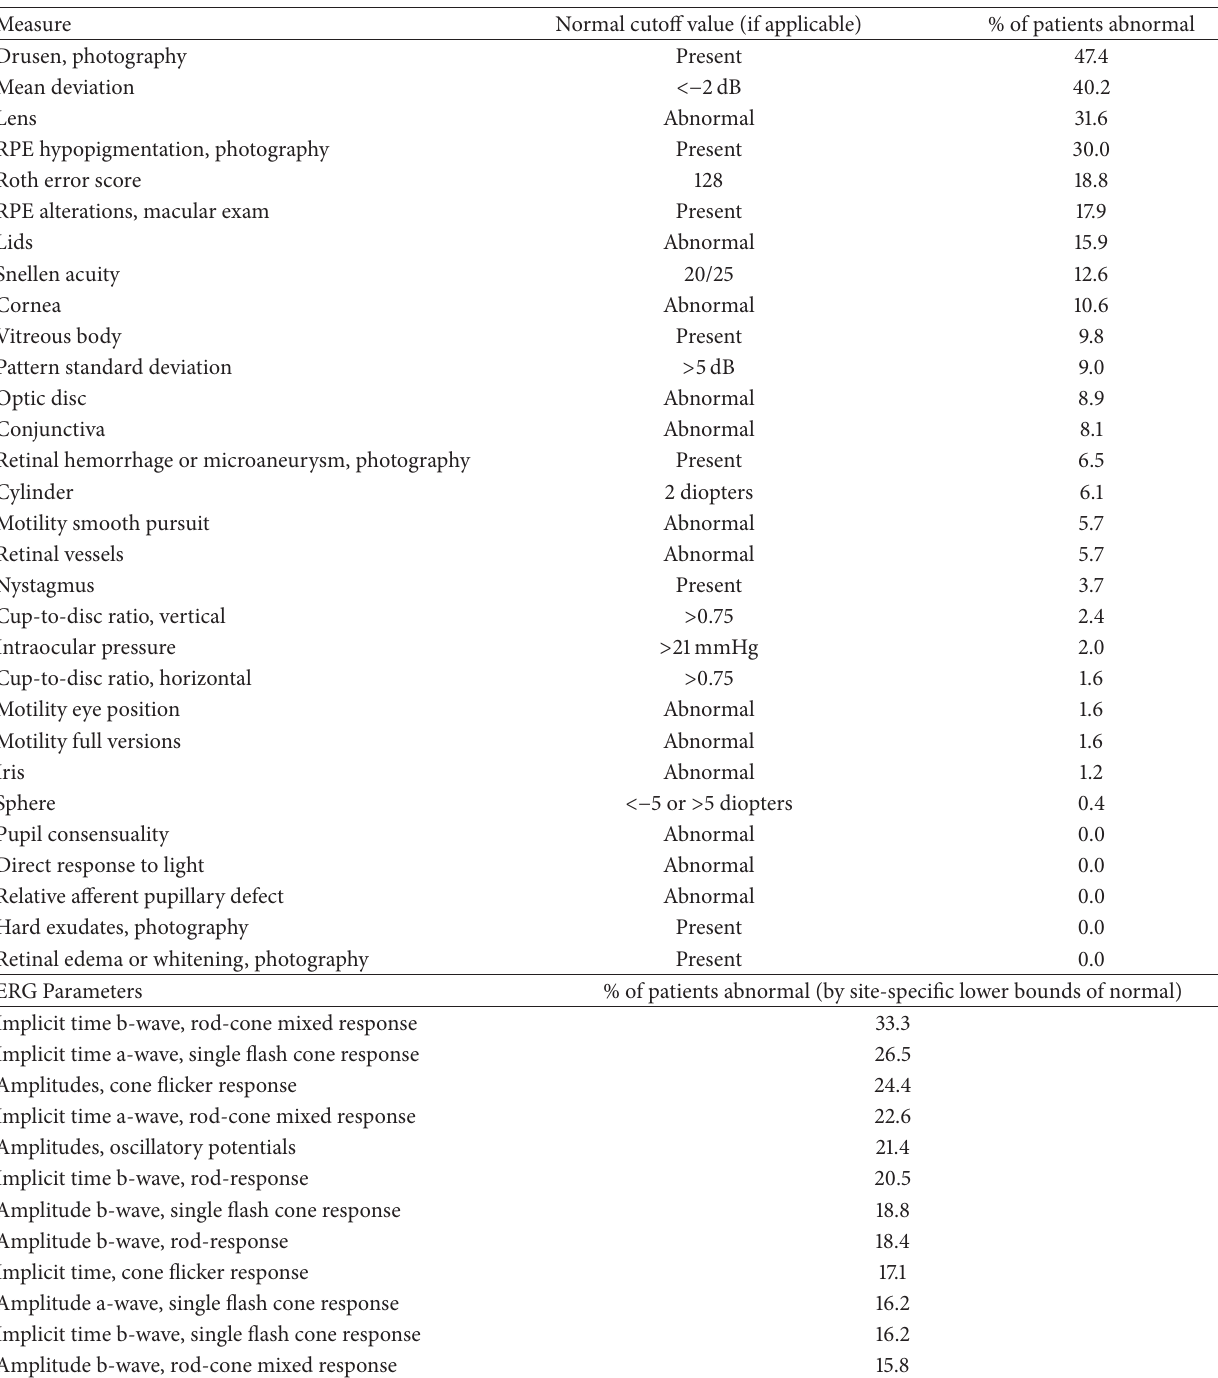
Table 2: Percentages of patients ( 𝑁 = 246 ) with abnormal ophthalmologic or ERG values at baseline (see text of baseline cross-sectional analyses). Normal cutoff values for non-ERG parameters are shown; patients’ ERG parameter abnormalities were scored against site-specific lower bounds of normal determined from 9 healthy control subjects per site. The Roth error score threshold for abnormality used in baseline analyses was lower than the Expert Panel’s threshold used for the on-treatment